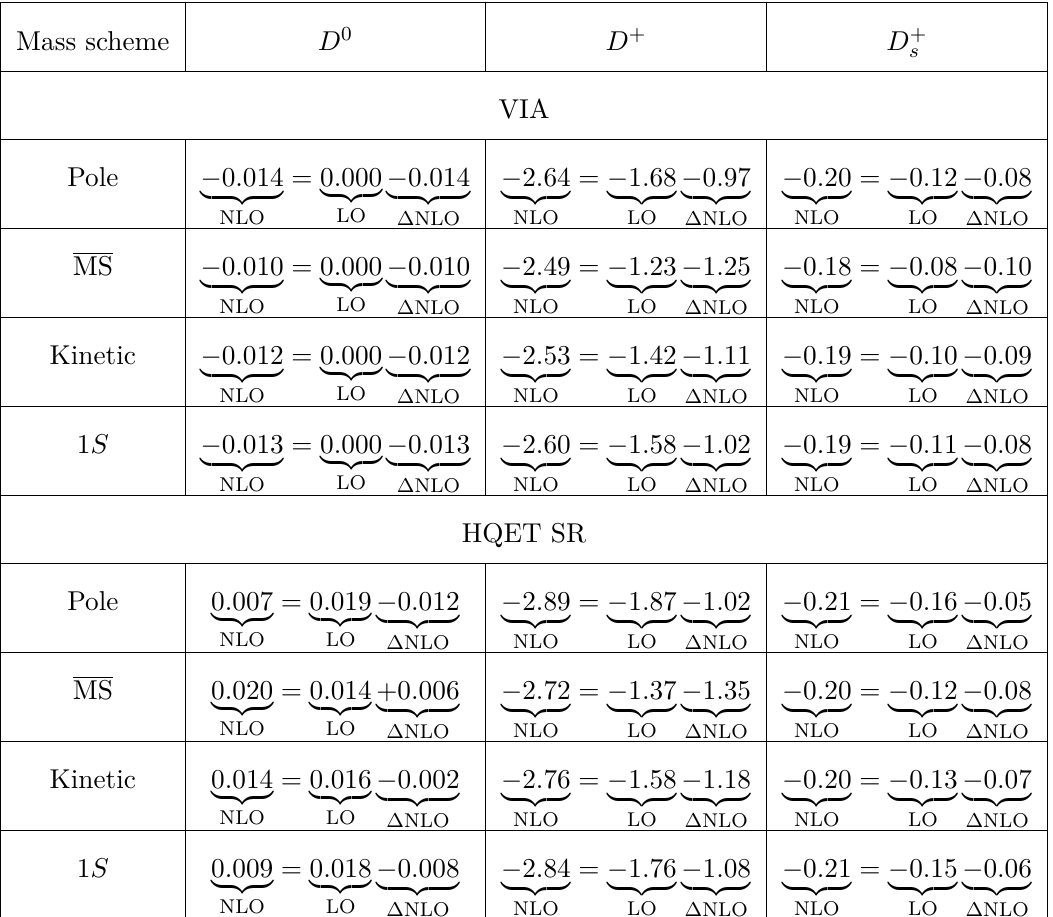
Table 9 . Dimension-six contributions to D -meson decay widths (see eq. (2.57)) (in ps − 1 ) and split up into LO-QCD and NLO-QCD corrections within different mass schemes and both in VIA and using the HQET SR for Bag